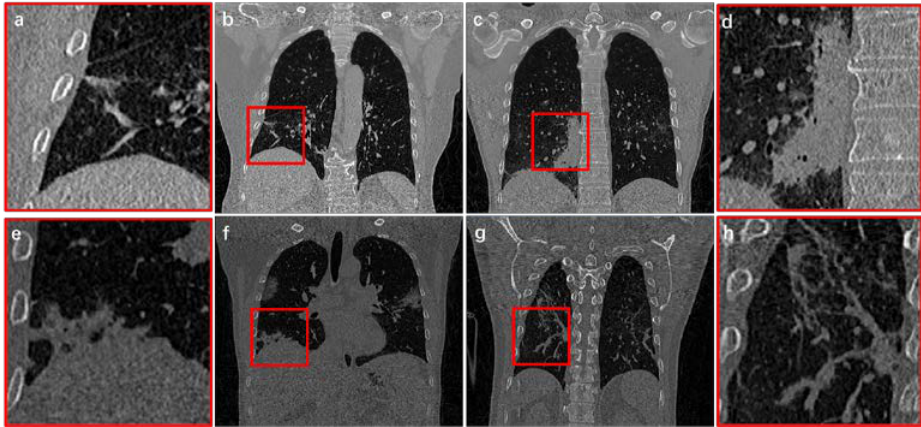
Figure 1. Infection structure from COVID-19 CT images. ( b , c , f , g ) indicate four different cases. ( a , d , e , h ) are the local magnification structure of the red boxes from ( b , c , f , g ), respectively.